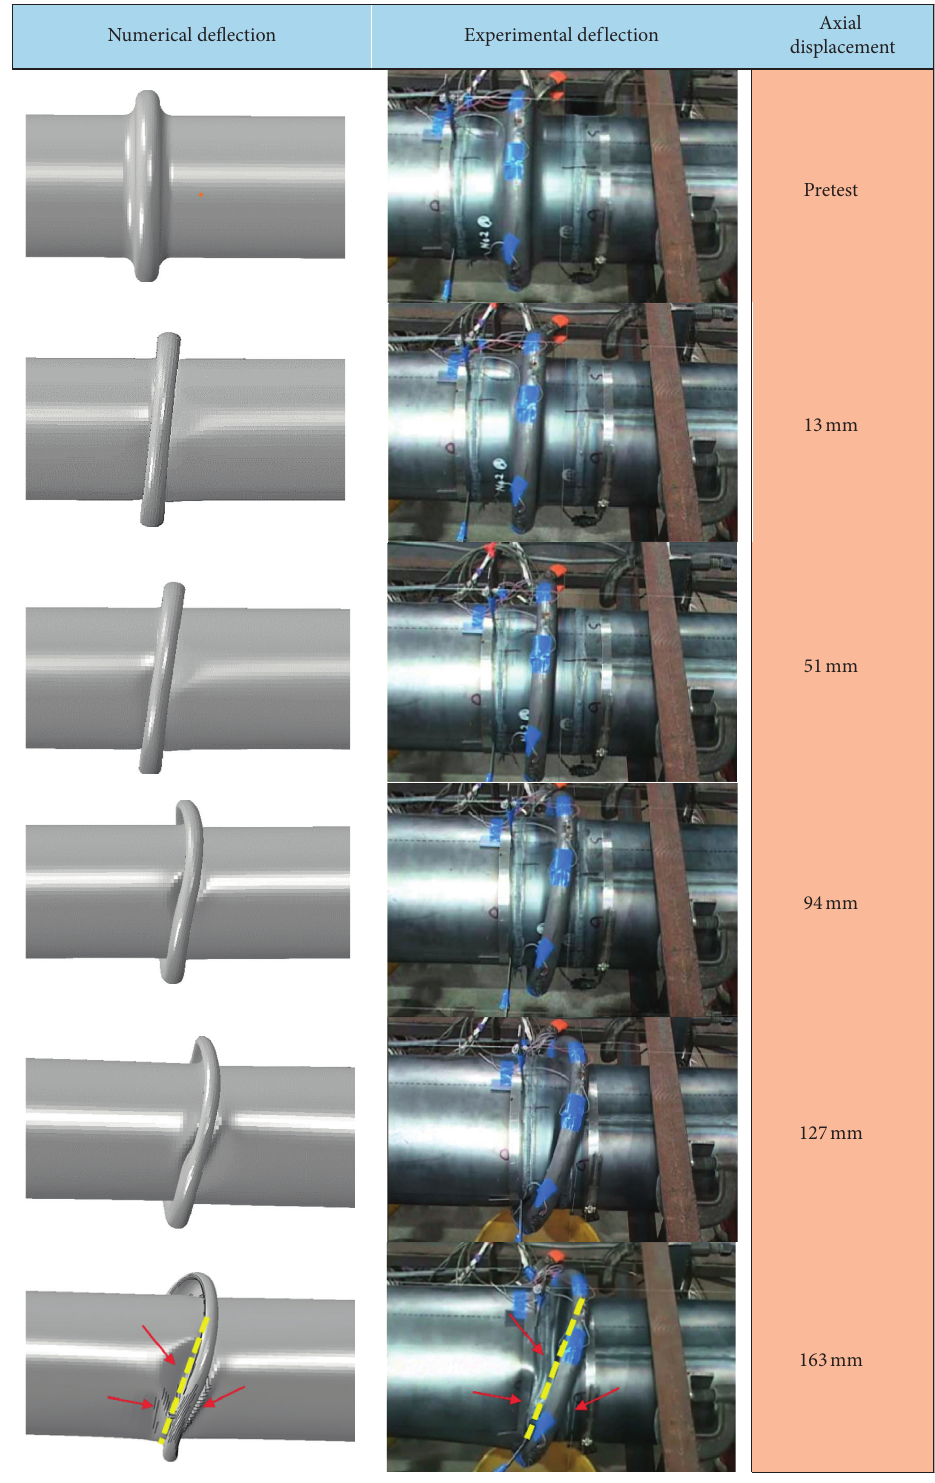
Figure 3: Comparison between deformed pipes of the experimental [34] and numerical